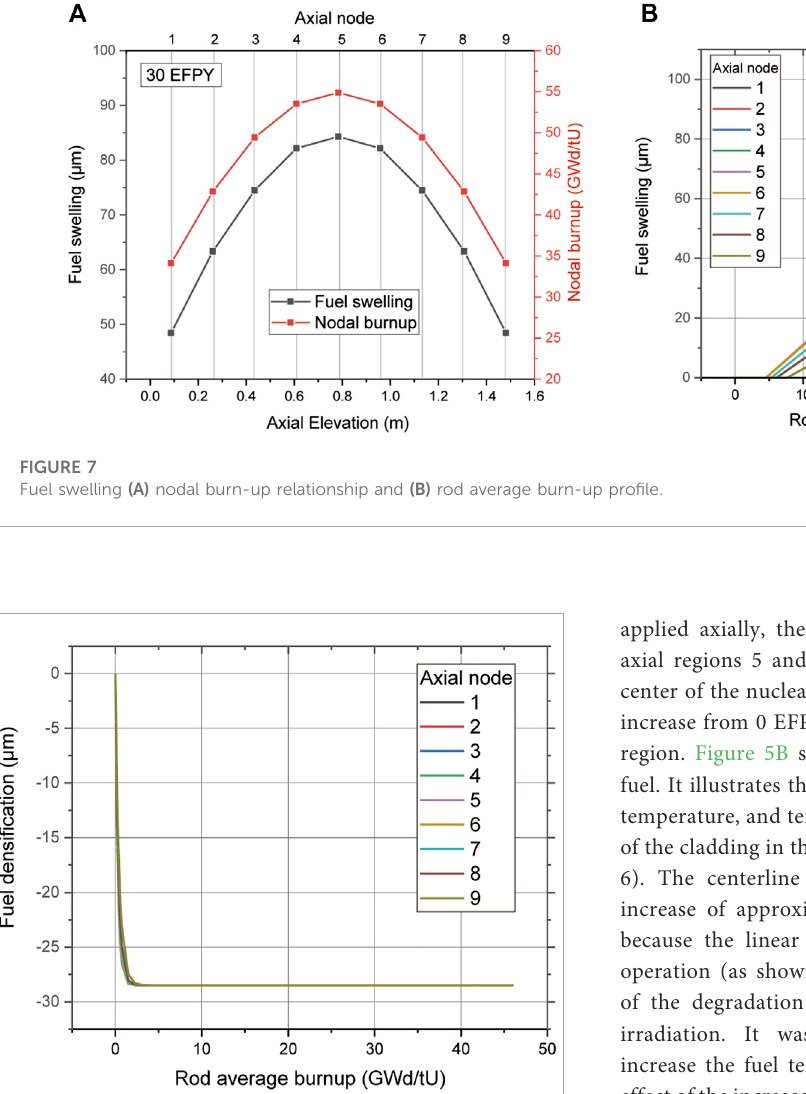
FIGURE 8 Fuel densi fi